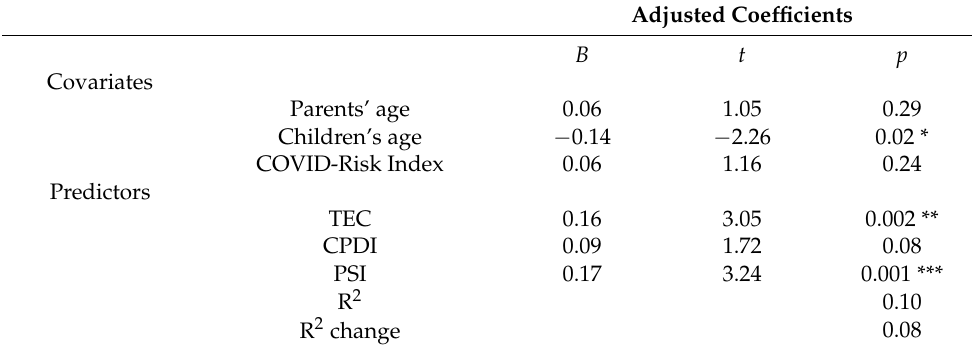
Table 2. Results of hierarchical multiple regression analyses predicting children’s psychological